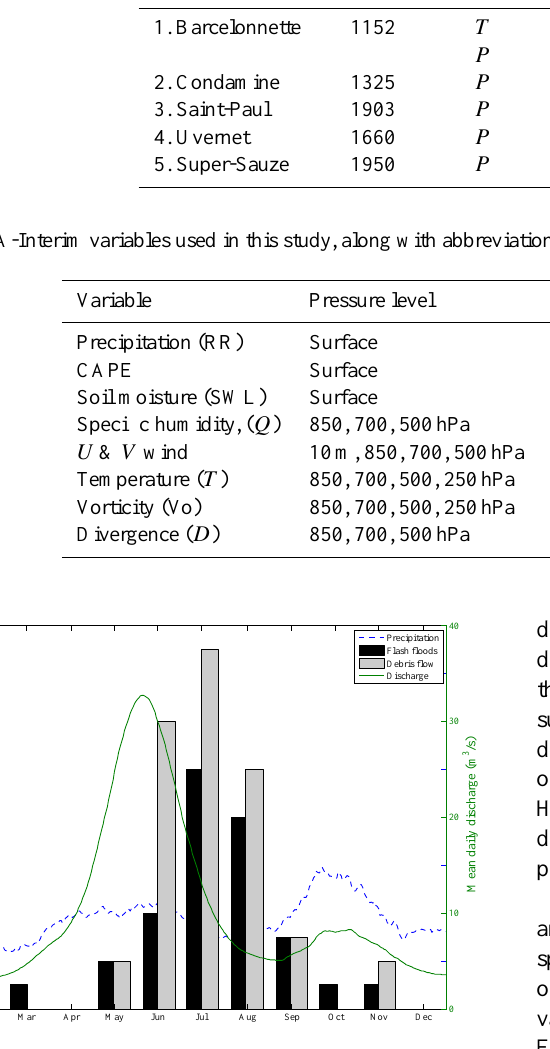
Figure 2. Running 30-day mean daily precipitation and discharge for the period 1979–2009, for the Barcelonnette weather station and river gauge in the Ubaye River. The bar graph displays the number of flash floods and debris flows observed between 1979 and